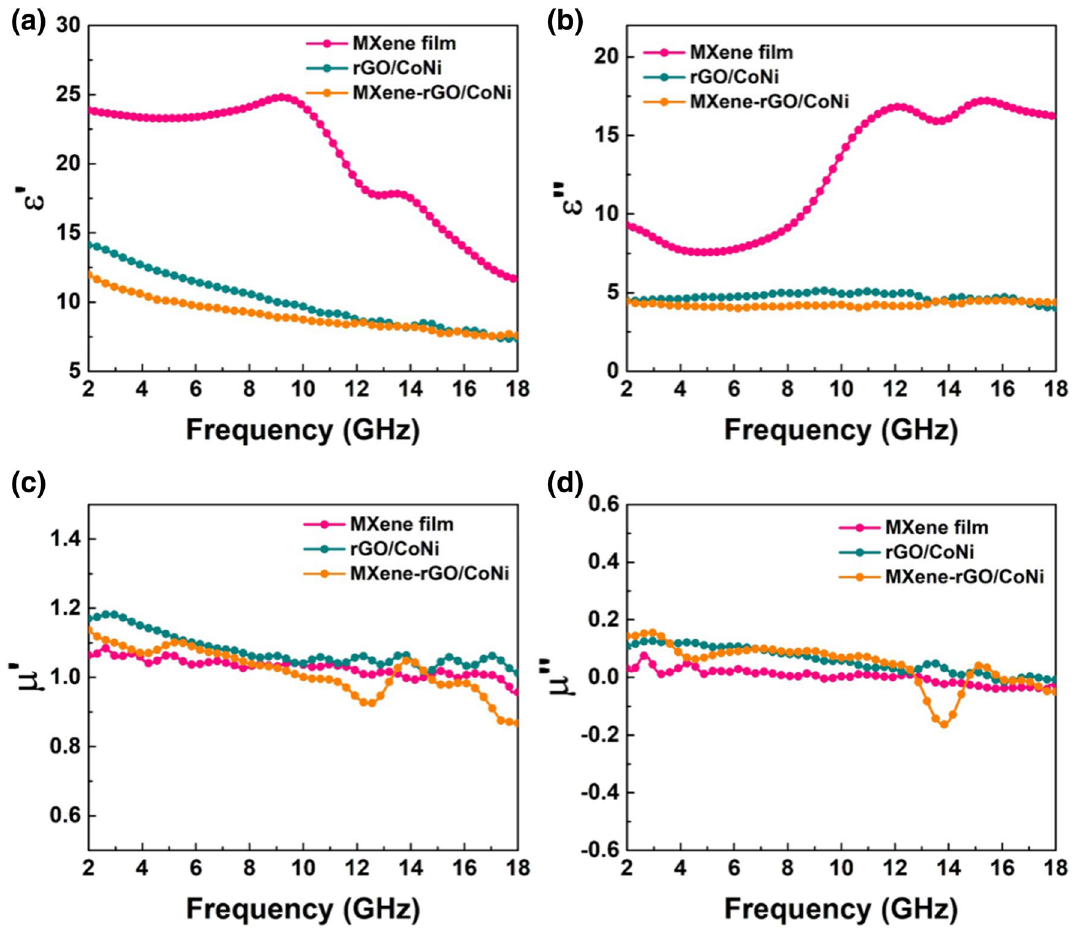
Fig. 6 a real part and b imaginary part of permittivity vs frequency, c real part and d imaginary part of permeability vs frequency of MXene, rGO/CoNi and MXene-rGO/CoNi